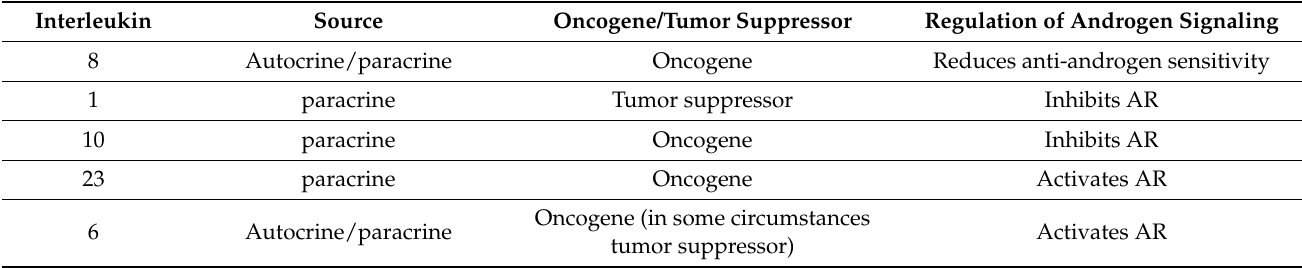
Table 2. Summary of interactions between important interleukins and the androgen signaling pathway in prostate cancer.